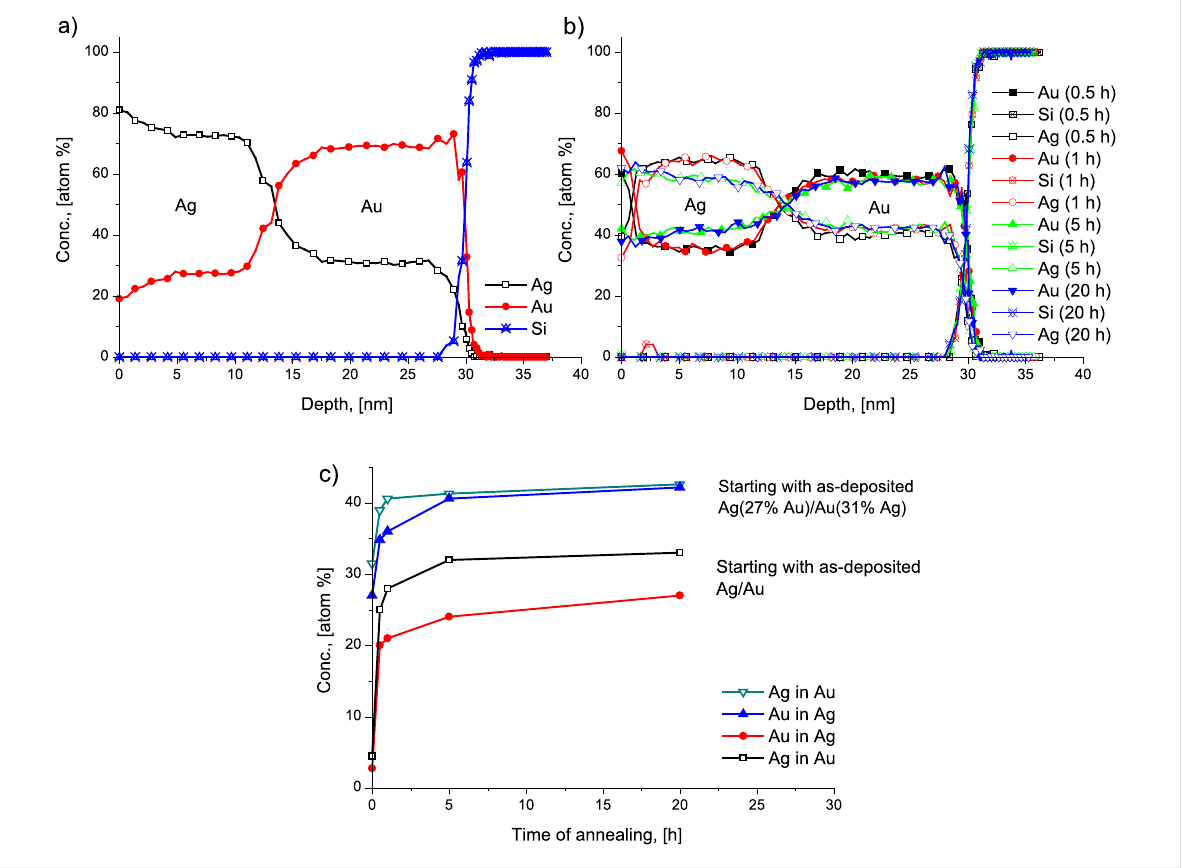
Figure 9: Concentration–depth profile of Ag(27% Au)/Au(31% Ag) bilayer, (a) as-deposited, (b) annealed at 170 °C for different annealing times and the average concentration of Au and Ag inside the Ag and Au layers versus annealing time at 170 °C in initially pure Ag/Au as well as Ag(27% Au)/ Au(31% Ag) bilayers